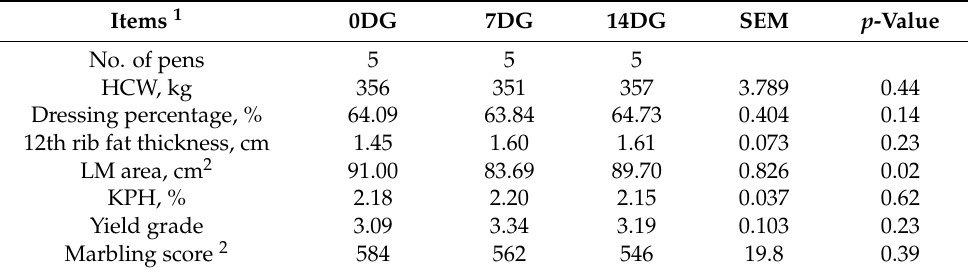
Table 4. Effect of distillers inclusion on carcass